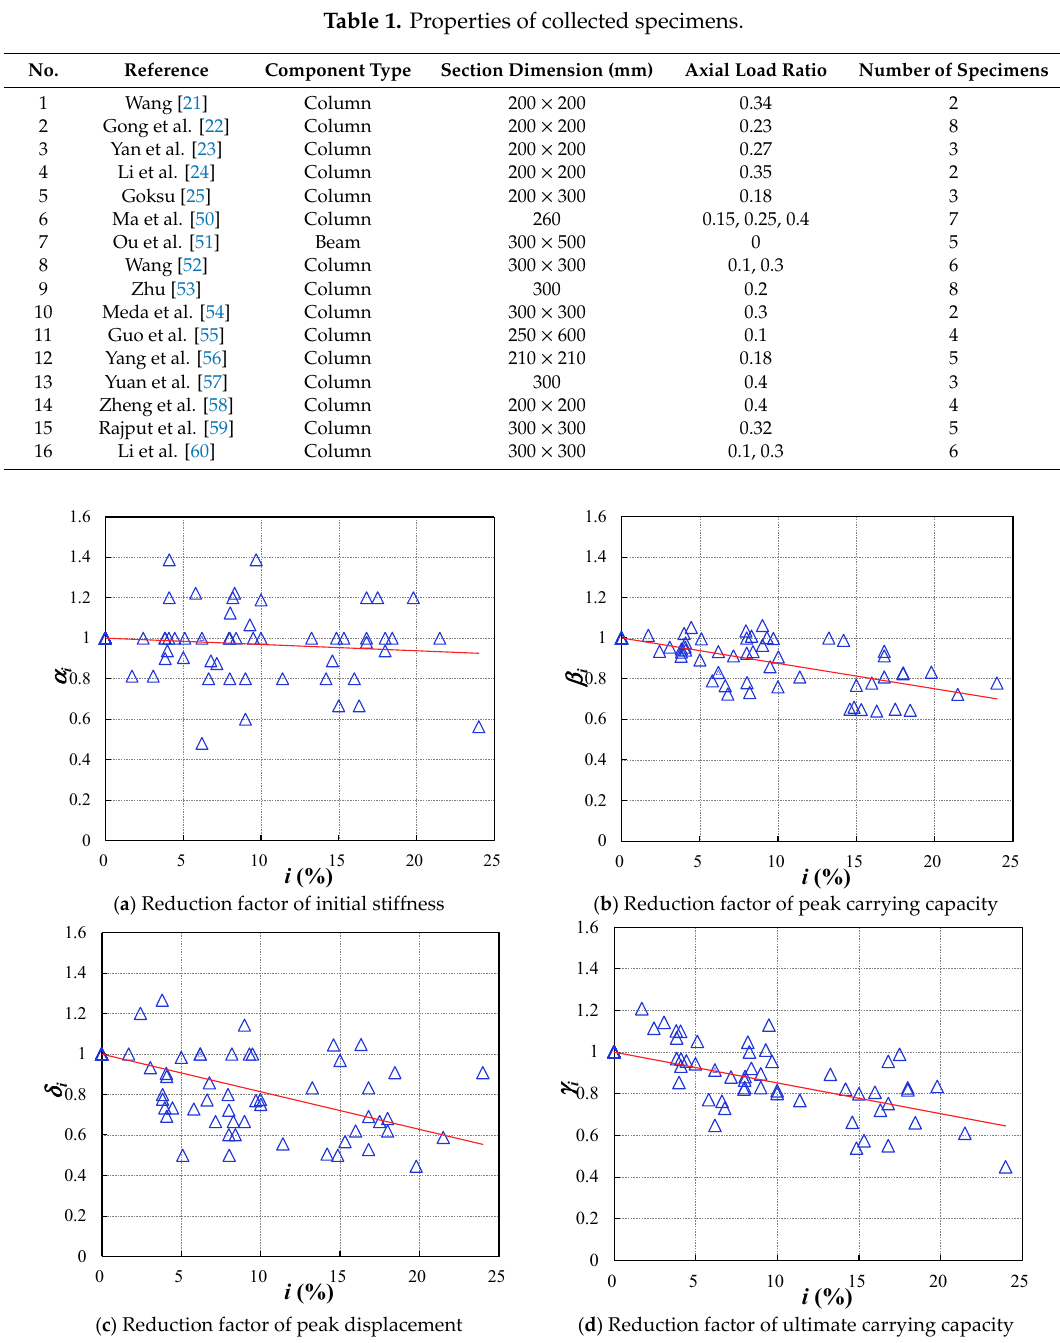
Figure 6. Reduction factors of key backbone curve parameters: ( a ) Reduction factor of initial stiffness; ( b ) Reduction factor of peak carrying capacity; ( c ) Reduction factor of peak displacement; ( d ) Reduction factor of ultimate carrying capacity.